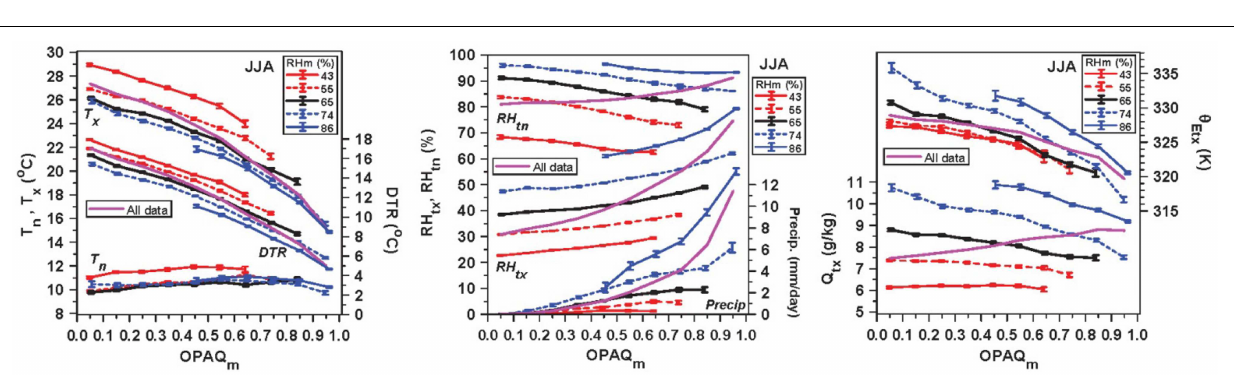
FIGURE 8 | Dependence of T x , DTR and T n (left), (middle) RH tx , RH tn , and precipitation, (right) Q tx and θ Etx on opaque cloud, partitioned by RH m